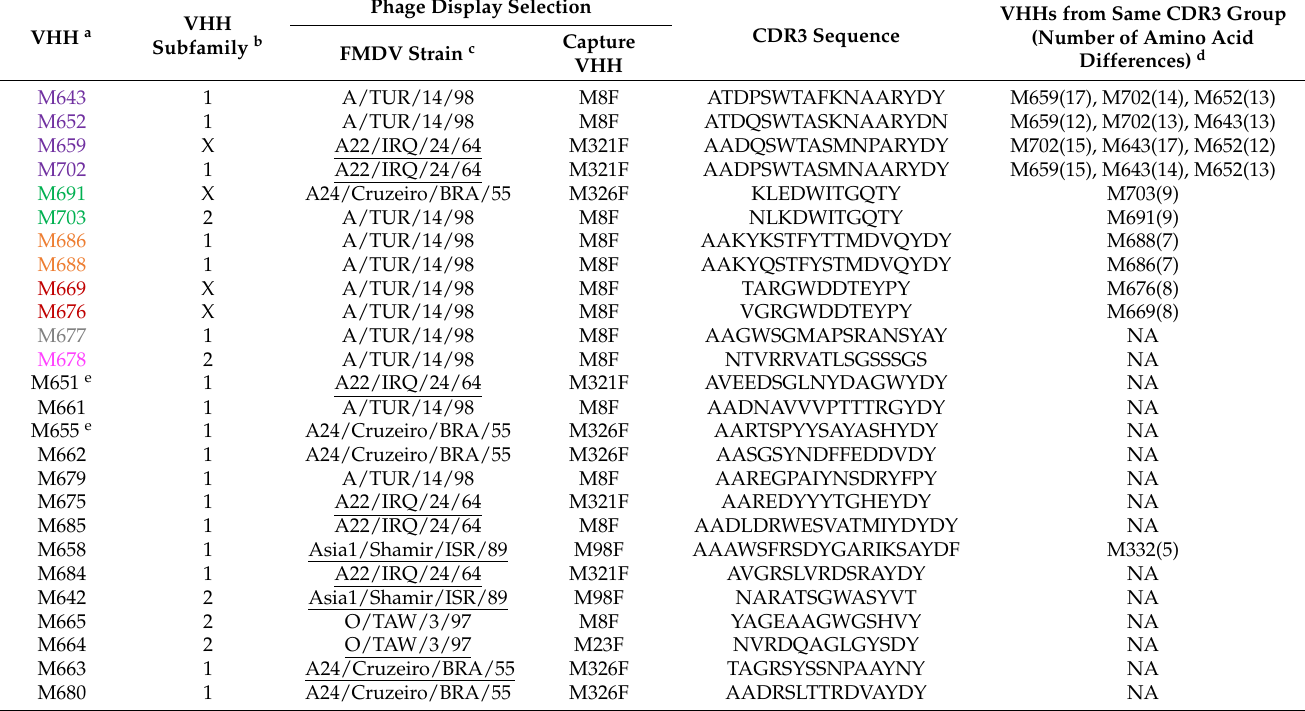
Table 2. Sequence and phage display selection information of 26 newly isolated